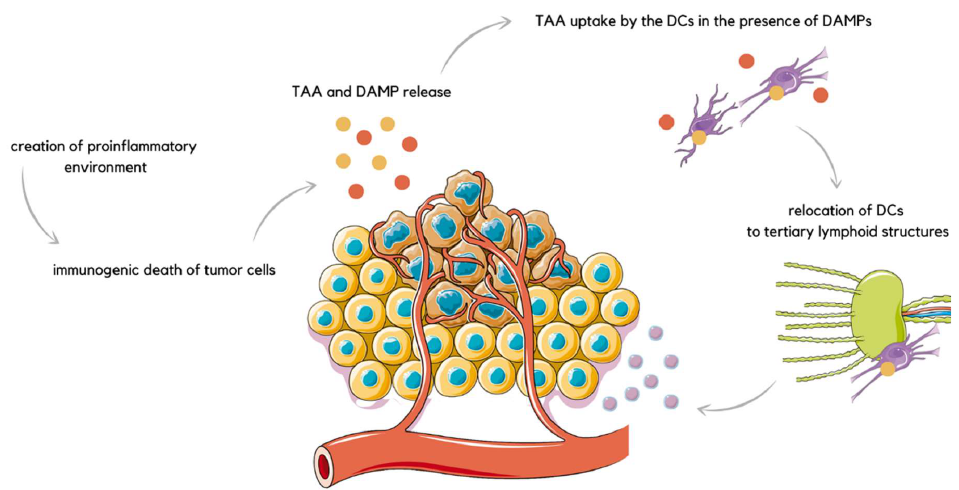
Figure 4. Schematic visualization of the role that EP plays in wound healing, allowing plasmid DNA to enter the cell via GET and therefore inducing an increase in either LL37 or VEGF level [75]. The Figure was partly generated using Servier Medical Art, provided by Servier, licensed under a Creative Commons Attribution 3.0 unported